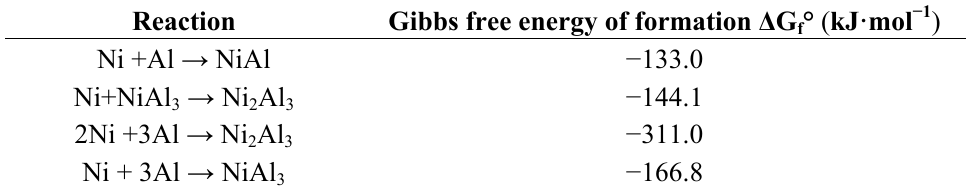
Table 4. Gibbs free energy of formation of some nickel aluminides [29].